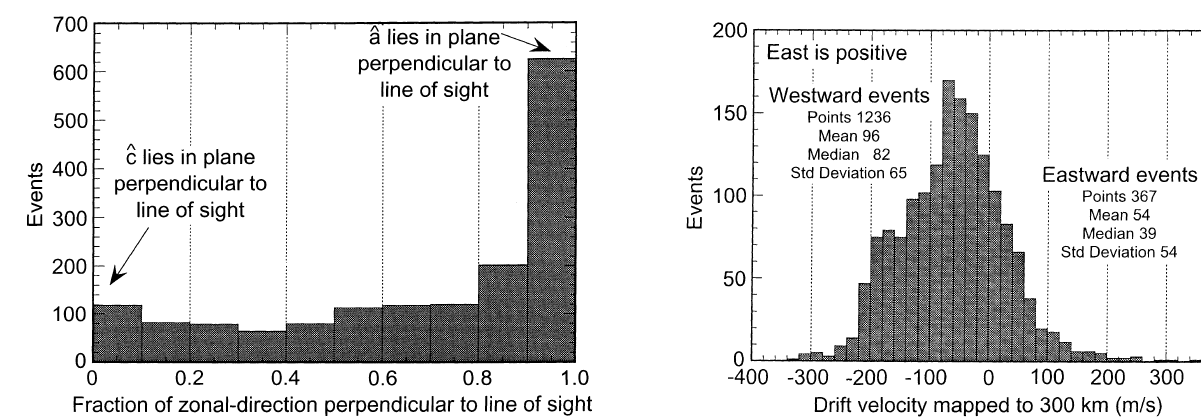
Fig. 12. The ratio of ^ a -perpendicular to the line of sight to the sum of ^ a -perpendicular and ^ c -perpendicular to the line of sight. This is a measure of the sensitivity of the instrument, for a particular line of sight, to drifts in the zonal, ^ a , direction